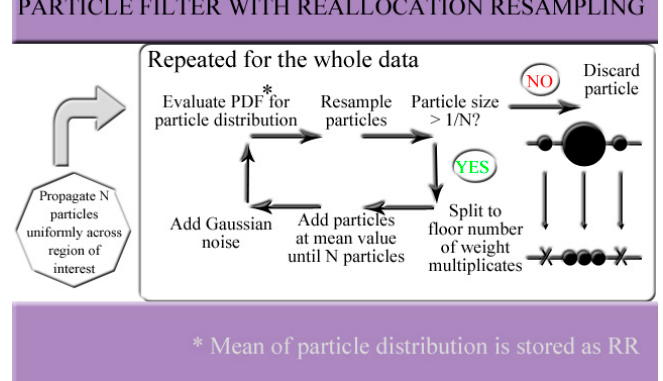
Figure 3. Structure of the proposed particle filter having reallocation resampling.